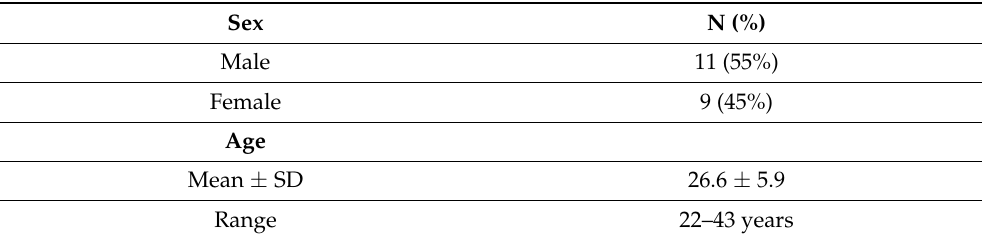
Table 1. A profile of the study subjects.